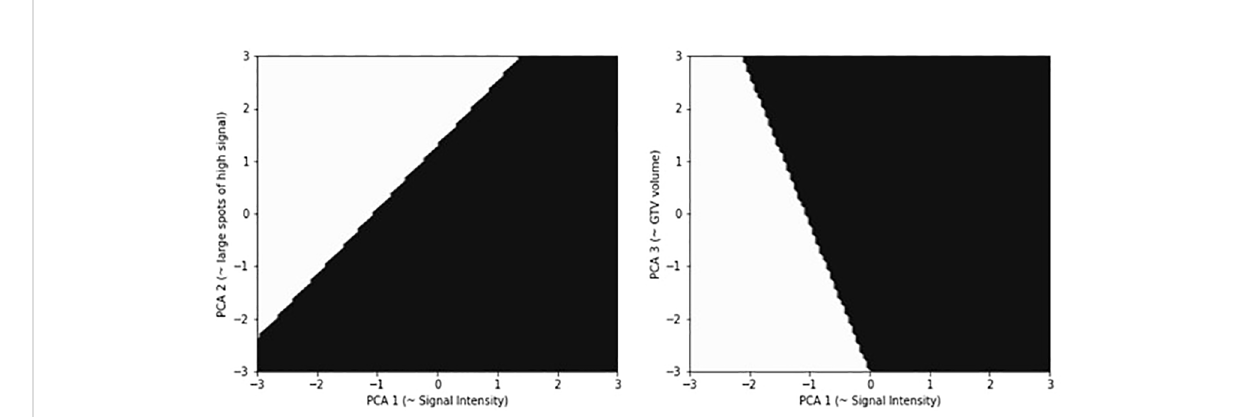
FIGURE 3 Results of the 3-component SVM classi fi cation. PCA component are normalized such that data have zero mean and variance one. In the image on the left, classi fi cation is based on Signal Intensity versus LAHGLE, in the image on the right is based on Signal intensity versus GTV. The white area is where the model predicts a relapse, the black area is where it predicts no relapse. For simplicity of explanation, we shall assume that PCA1 is SI, PCA2 is GLSZM ’ s LAHGLE, PCA3 is GTV volume. the relapses are on the left side of both panes. Since both panes have SI as horizontal axis, it is con fi rmed that a lower SI correlate with a higher risk of relapse. In the left pane the vertical axis is LAHGLE, and relapses are in the upper part, higher LAHGLE has a positive correlation with relapse. In the right pane GTV is on the vertical axis and with a similar reasoning we can conclude that a smaller GTV volume correlates with relapse. The risk of relapse depends on a combination of the three parameters since the cut-off between relapse and non-relapse is never a horizontal or vertical